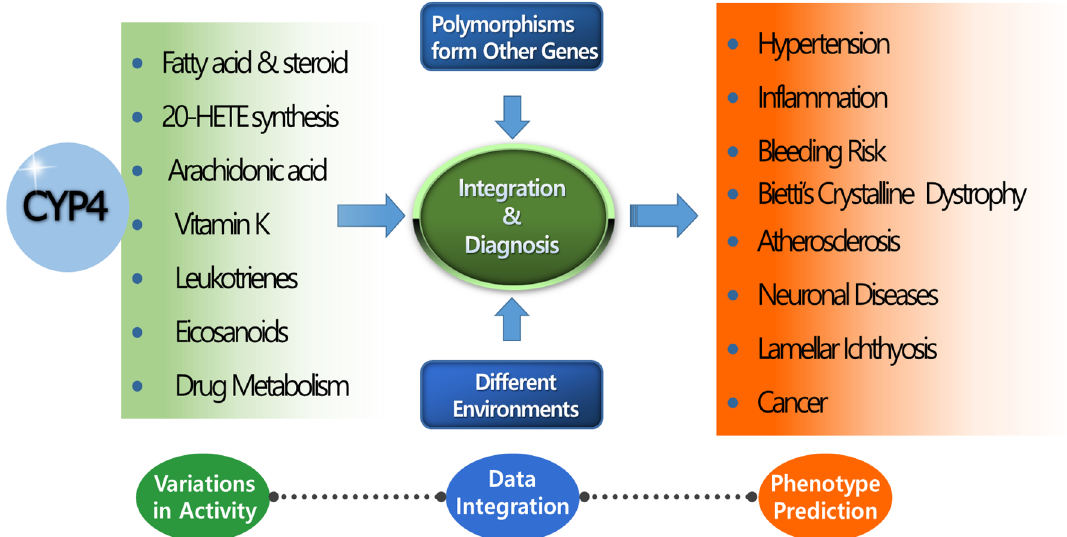
Figure 2. Correlation of CYP4 genes with phenotypic outcomes. Most CYP4 genes share similar structures and overlapping metabolic substrates. Phenotypic outcome prediction is difficult with a single or few CYP4 genetic studies. Phenotypic outcomes are affected by genetic polymorphisms of various genes and dynamic environmental factors. Fundamental research into CYP4 genes is essential to provide the data integration necessary for more accurate phenotype prediction than can be obtained using conventional methods.